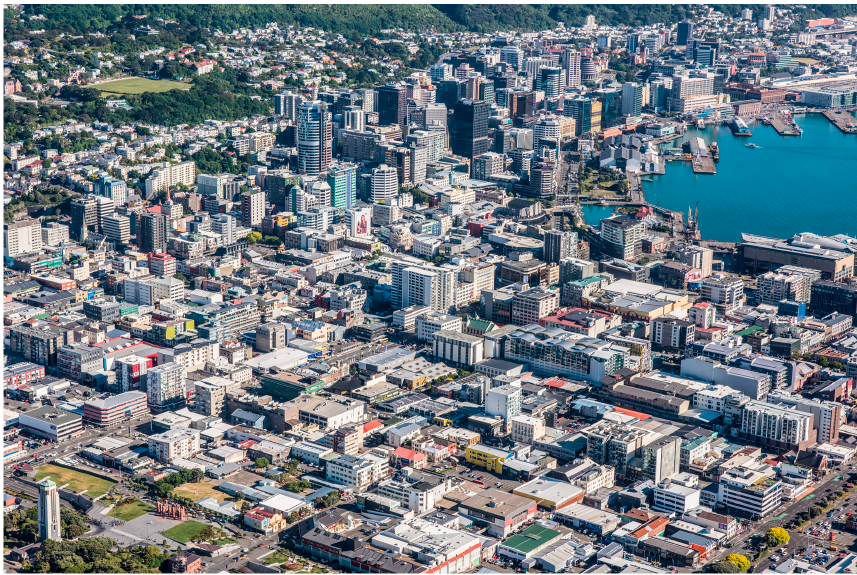
Figure 1. Wellington Central Business District with apartment dwellings (image courtesy of Victoria University of Wellington).